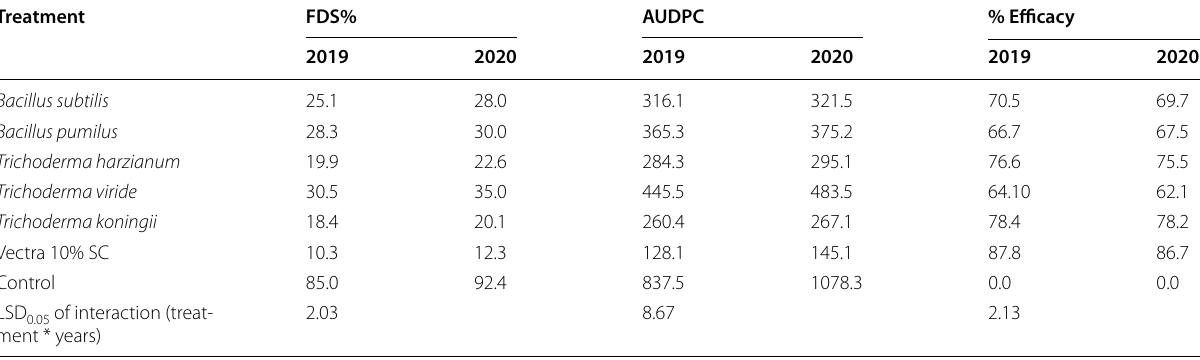
Table 3 Effects of certain treatments on final disease severity (%), area under disease progress curve (AUDPC) and efficacy (%) for controlling powdery mildew disease of sunflower plants, during 2019 and 2020 seasons Treatment FDS% AUDPC % Efficacy